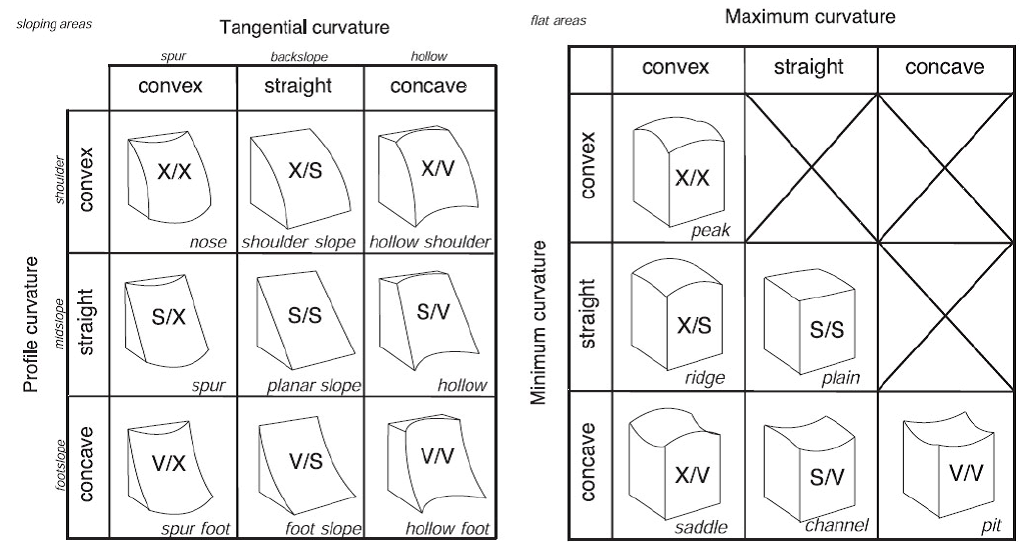
Figure 7. Fifteen “form elements” offered by [59] based on local geometry. (X = convex, V = concave, S = straight).